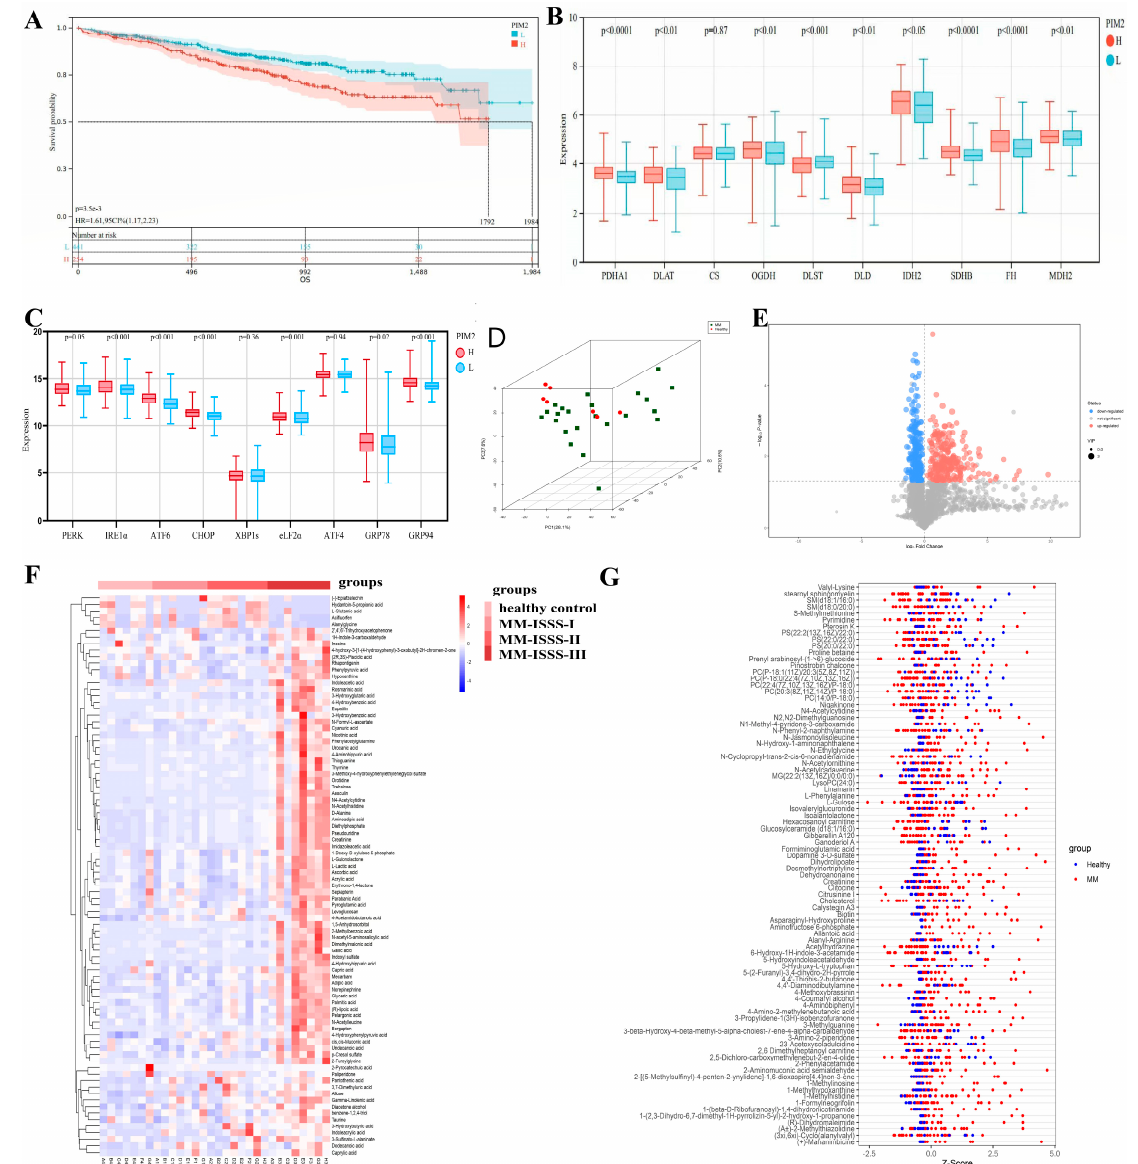
Figure 1. High expression of Pim-2 kinase correlates with poor prognosis and genes involved in energy metabolism and endoplasmic reticulum stress in MM patients. ( A ). Survival curves of MM patients by subgrouping according to Pim-2 expression. L means MM patients with low expression of Pim-2. ( B ). Association of pim2 expression levels with gluconeogenesis-related genes. L means MM patients with low expression of Pim-2. H means MM patients with high expression of Pim-2. ( C ). Association of pim2 expression levels with endoplasmic reticulum stress-related genes. ( D ). A 3D score scatter plot of a PCA model for group MM vs. HC. Samples are all at 95% confidence intervals. ( E ). Most metabolites of MM patients were increased. Significantly upregulated metabolites are depicted in red, significantly downregulated metabolites in blue, and non-significantly differential metabolites in gray. ( F ). The concentration of most metabolites in high-risk MM patients is high. The abscissa of the plot represents different experimental groupings, the ordinate represents the differential metabolites contrasted by the group, the color block at different positions represents the relative expression of the metabolite at the corresponding position, red indicates that the substance is highly expressed in the group where it is located, and blue indicates that the substance is lowly expressed in the group where it is located. ( G ). Metabolite content in MM patients was significantly increased. The abscissa represents the Z value, the ordinate represents the differential metabolites, and the dots in different colors represent samples in different